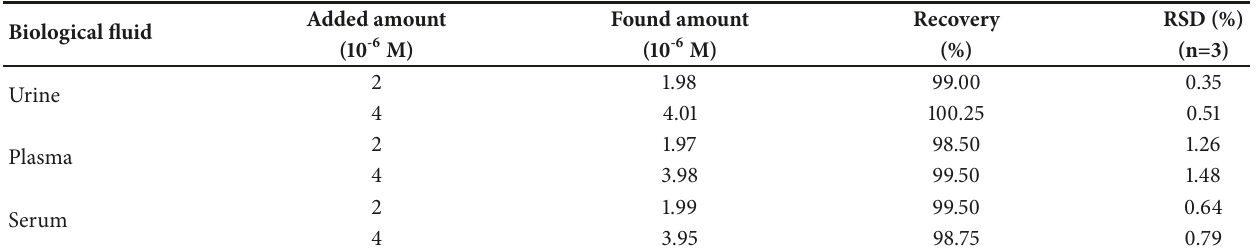
Table 4: Recovery of Etoposide from the biological human fluids.